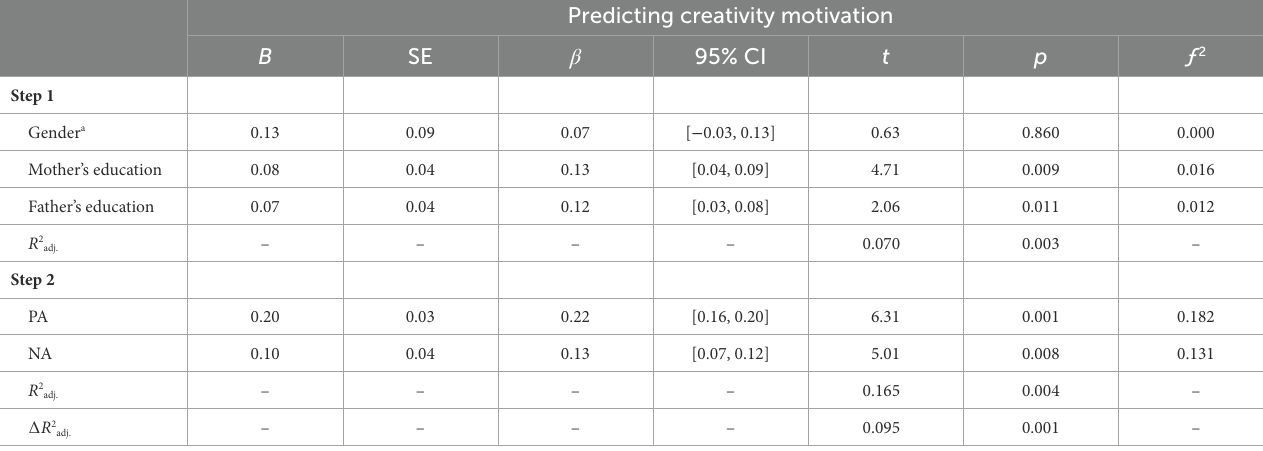
TABLE 2 Results of hierarchical regression analyses predicting creativity motivation in study 1 ( n = 588).